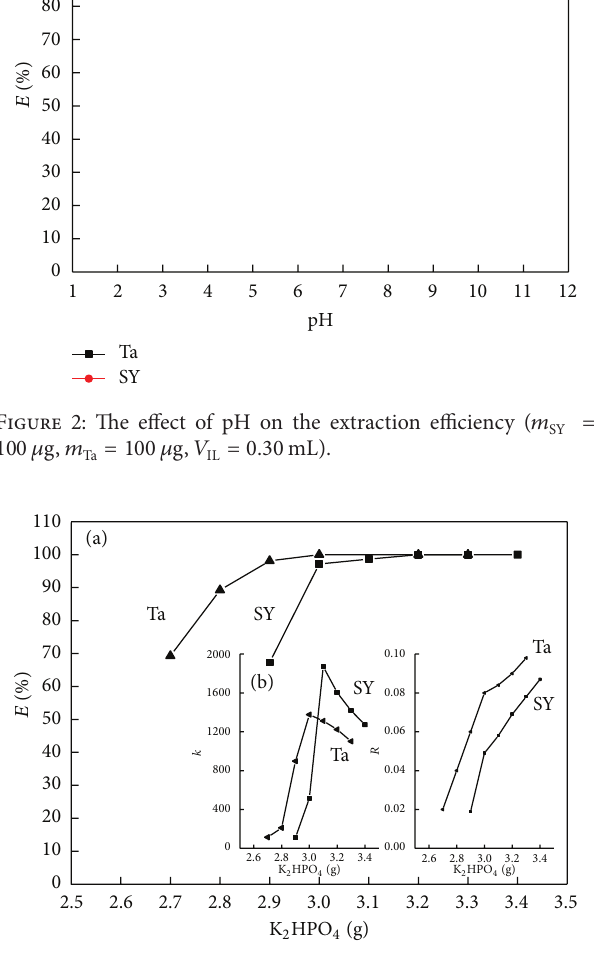
= 100 𝜇 g, 𝑚 = 100 𝜇 g, SY Ta